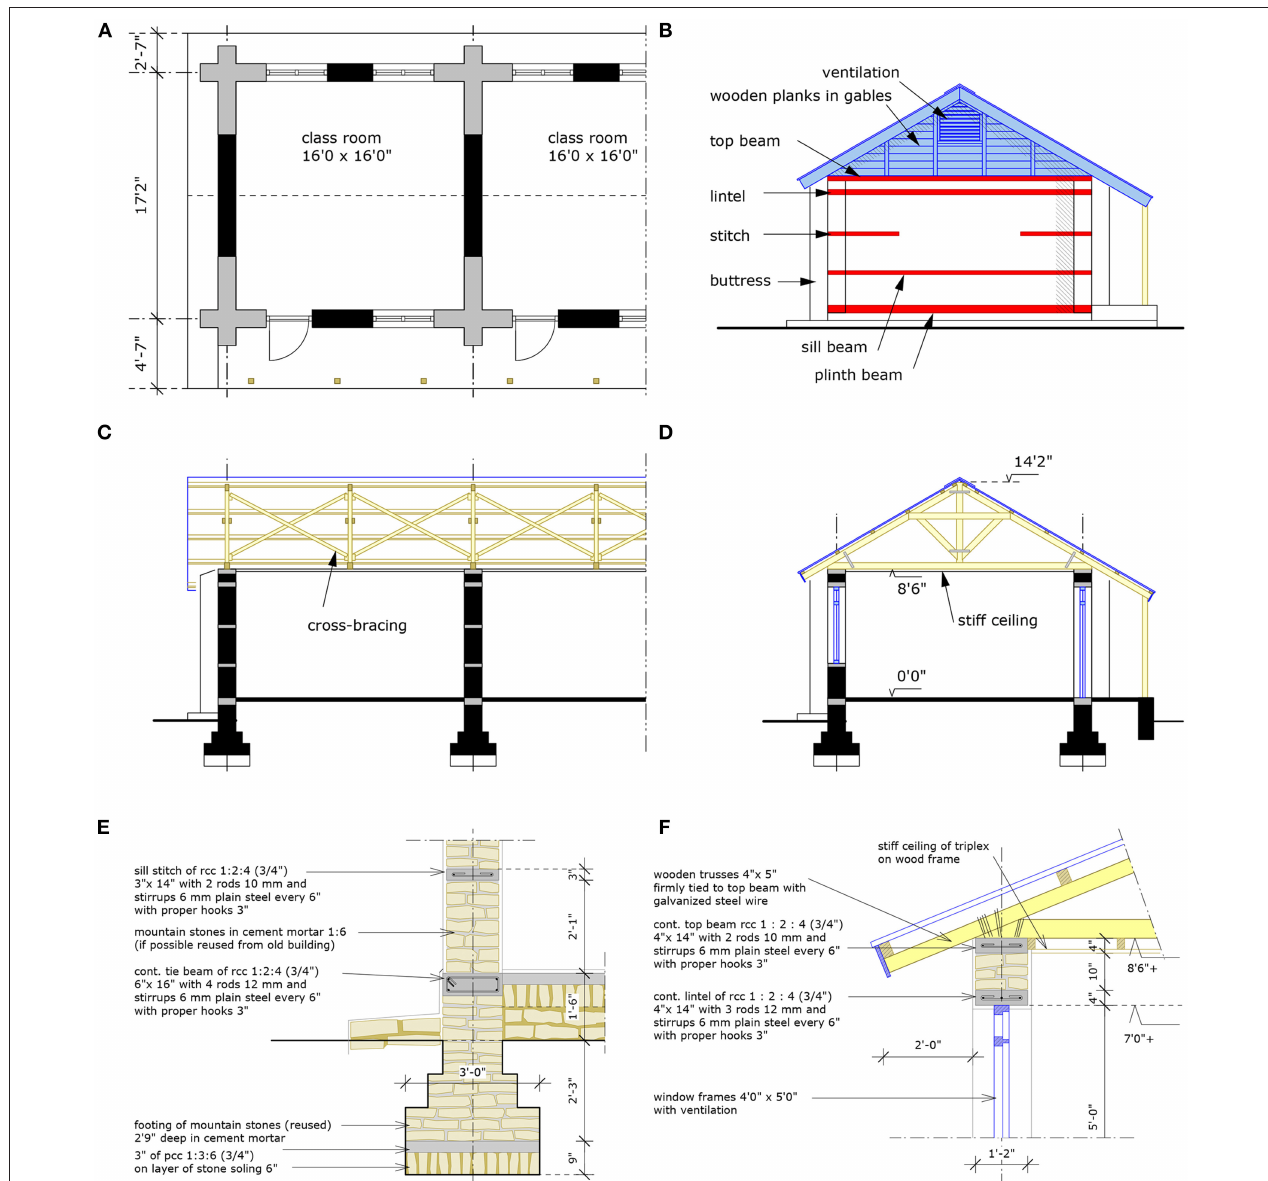
top beam is also fully continuous. Different thicknesses of the beams, as well as different numbers and diameters for the steel reinforcements were